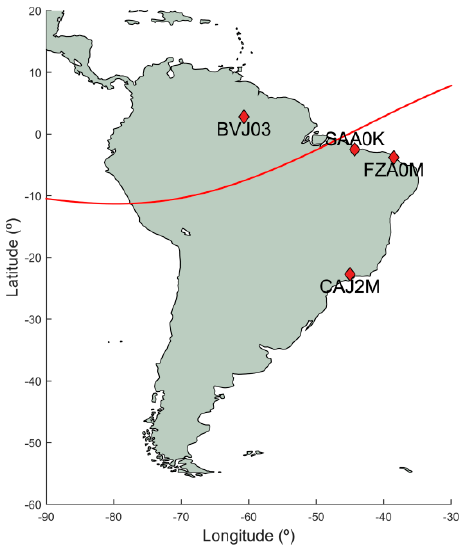
Figure 1. Location of the four ionosondes used for the GIMs assessment.